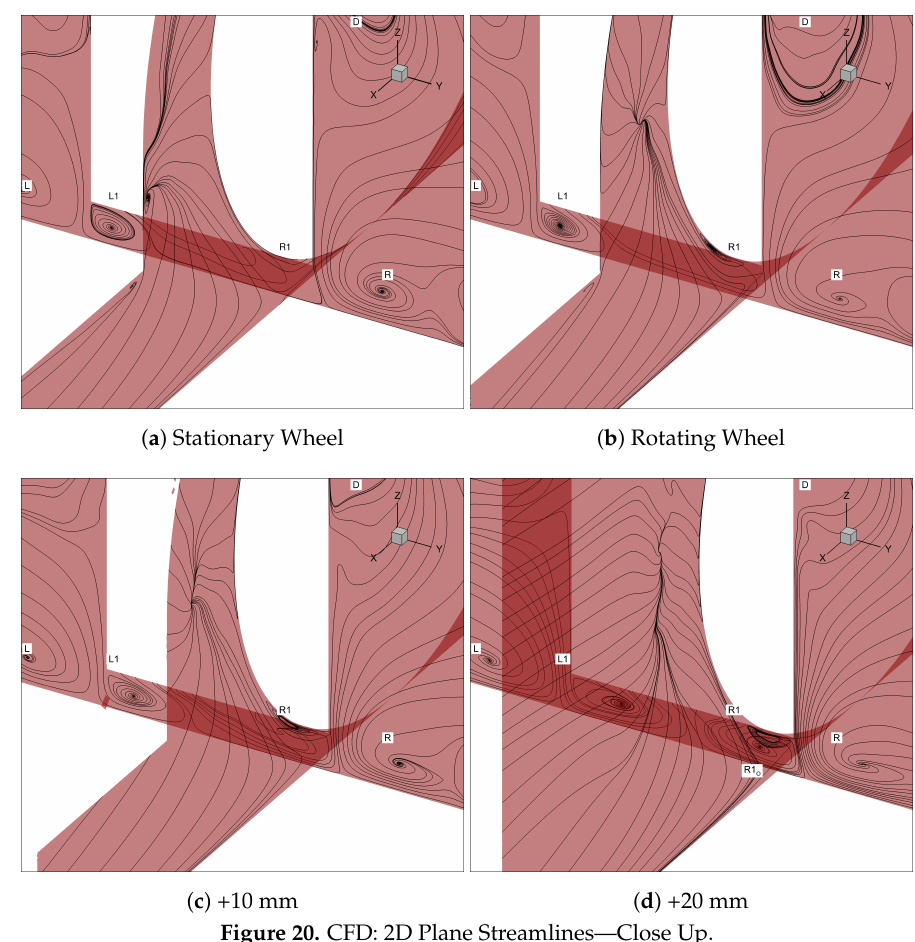
Figure 20. CFD: 2D Plane Streamlines—Close